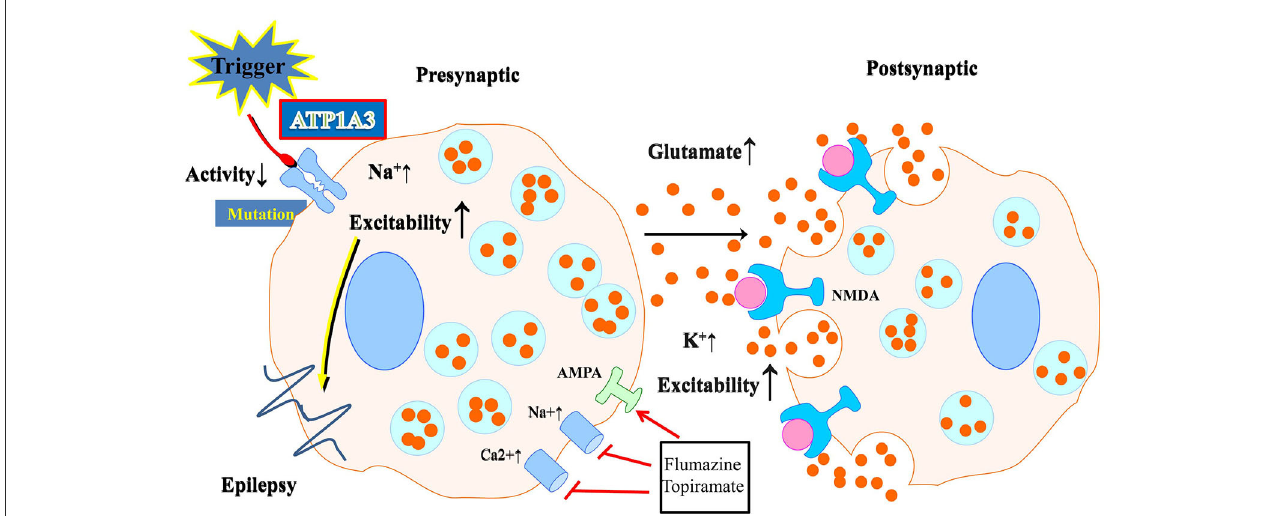
FIGURE2 Schematic illustration of the effect of neuronal ATP1A3 mutations on glutamatergic system activity. Abnormalities in Na + /K + -ATPase may result from mutations. Neurons with an ATP1A3 mutation have increased cellular excitability due to decreased Na + /K + -ATPase activity and increased intracellular Na + . Flunarizine and topiramate could be used as a treatment in some relevant disease